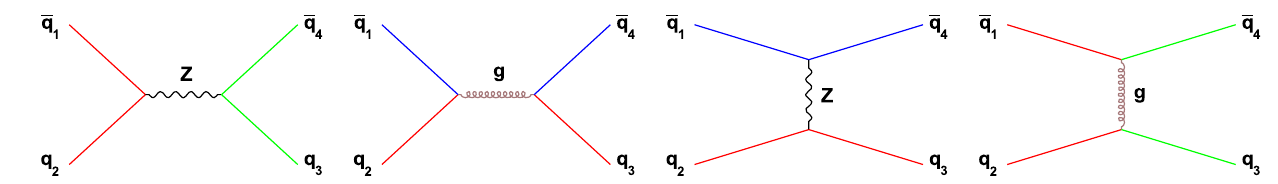
Fig. 1 The leading order qq → qq diagrams, with s - and t -channel Z and gluon processes. The Z could be replaced by a W or photon